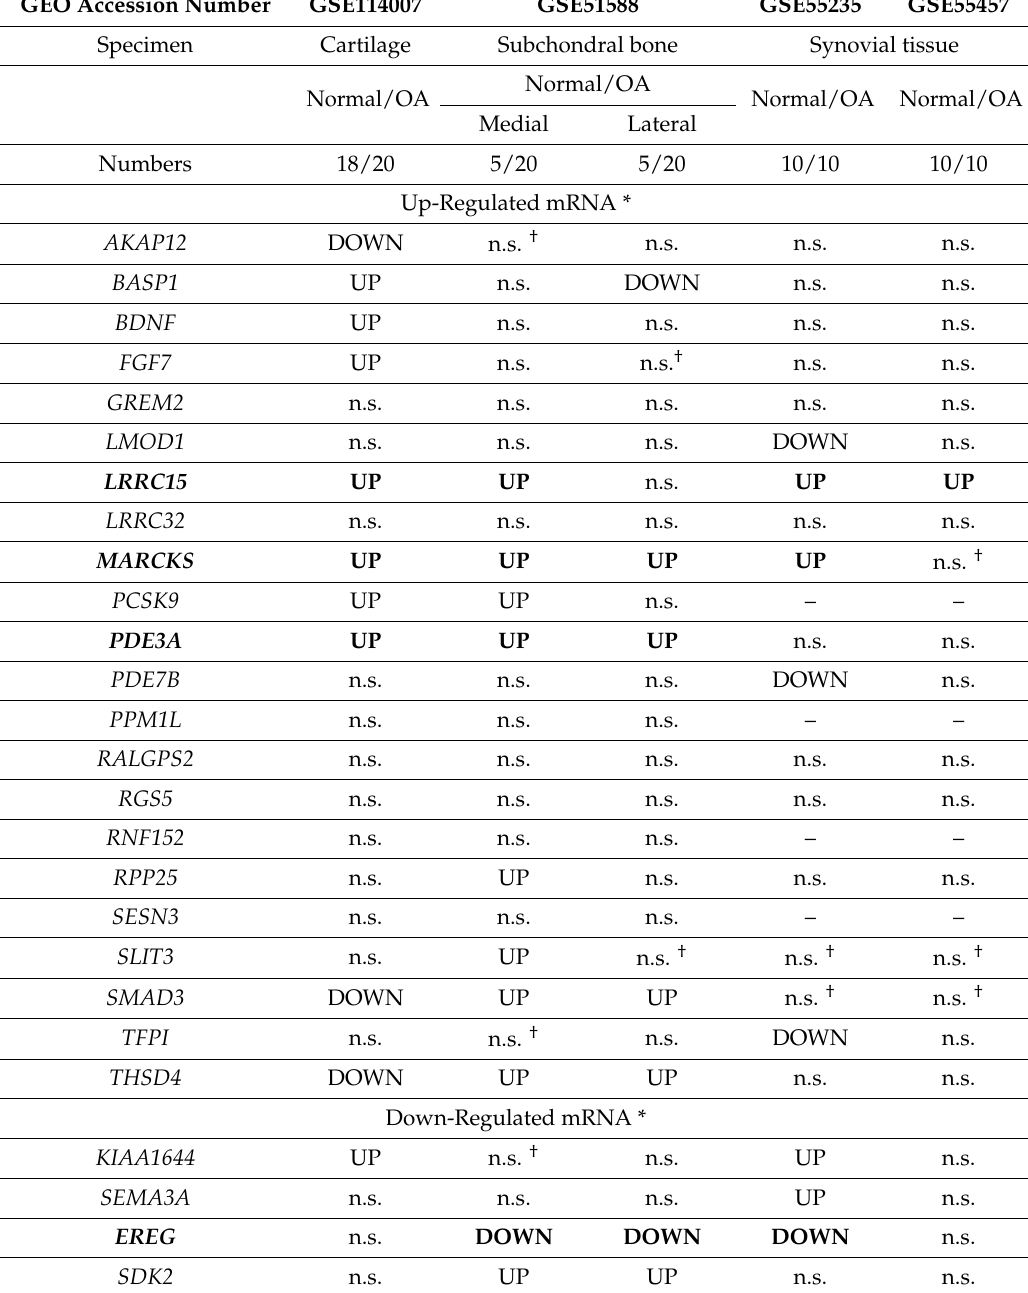
Table 4. Analysis of 26 candidate genes in osteoarthritis-related datasets in Gene Expression Omnibus